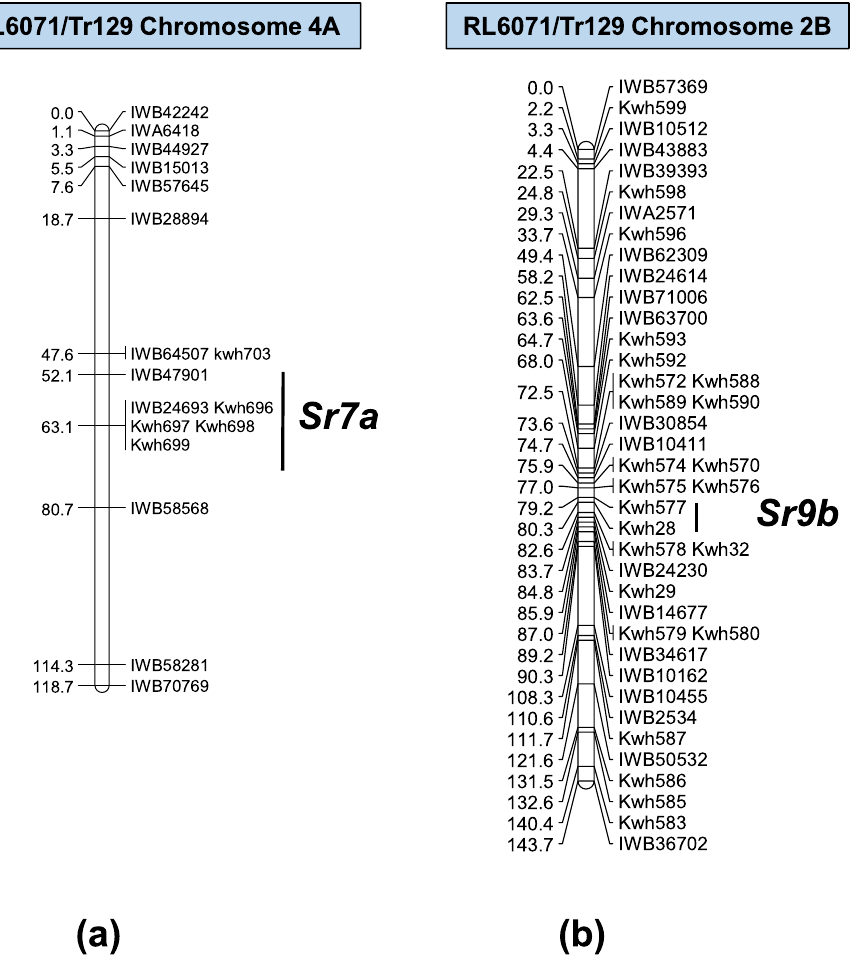
Figure 3. Linkage maps developed for Subset 2 DH lines. ( a ) Sr7b mapped at 63.1 cM on chromosome arm 4AL; ( b ) Sr9b mapped at 79.2 cM on chromosome arm 2BL. Kompetitive allele specific (KASP) PCR markers designated as kwh developed in the present study are shown on the linkage maps. Primer information is provided in supplementary table S7.